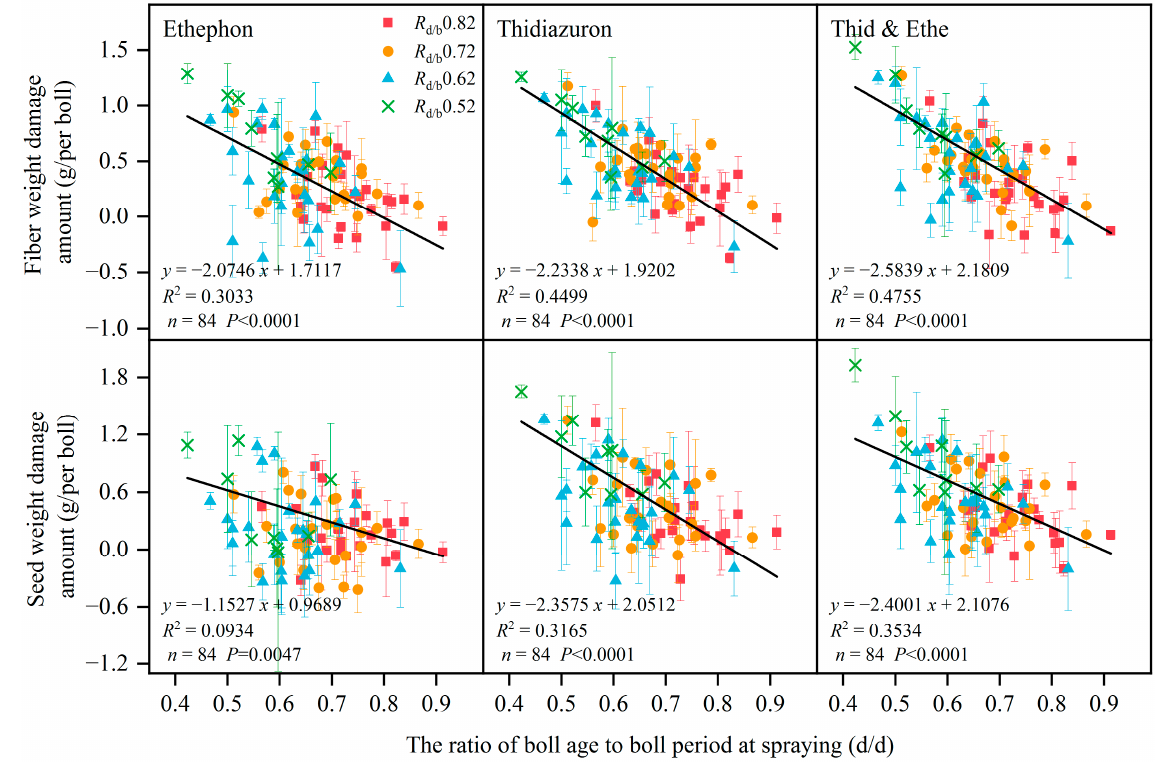
Figure 5. The quantitative relationship between the amount of damage to a single boll component and the R d/b value. The R d/b value in the figure indicates the ratio of the cotton boll age (d) when the harvest aids were sprayed in the control during the boll period (b), and the control boll period (b) is the boll period that was not sprayed with harvest aids.